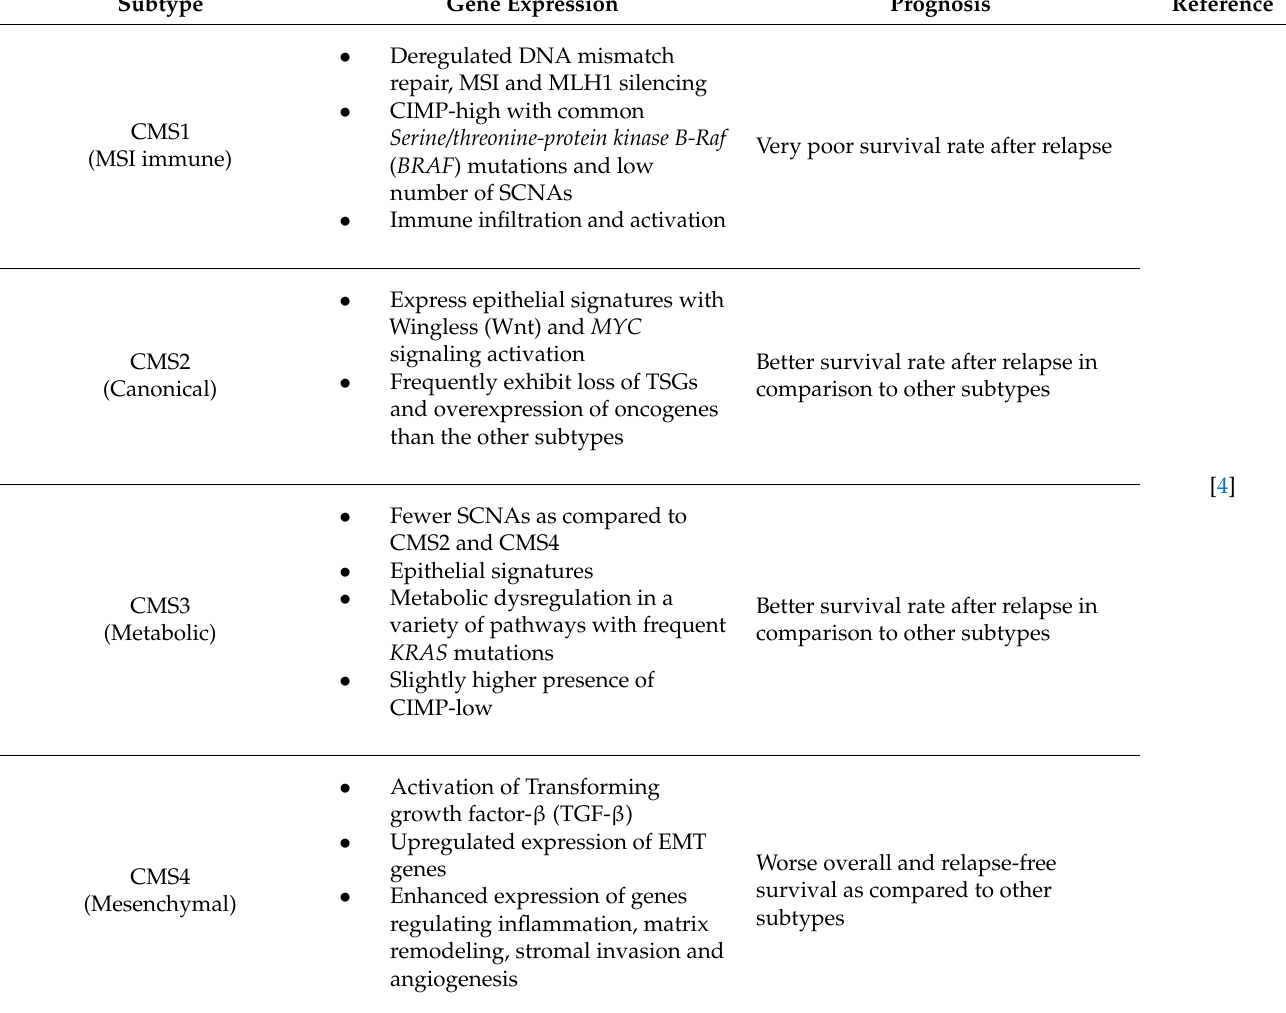
Table 1. Biological differences in the gene expression-based molecular subtypes of colorectal cancer (CRC). Subtype Gene Expression Prognosis